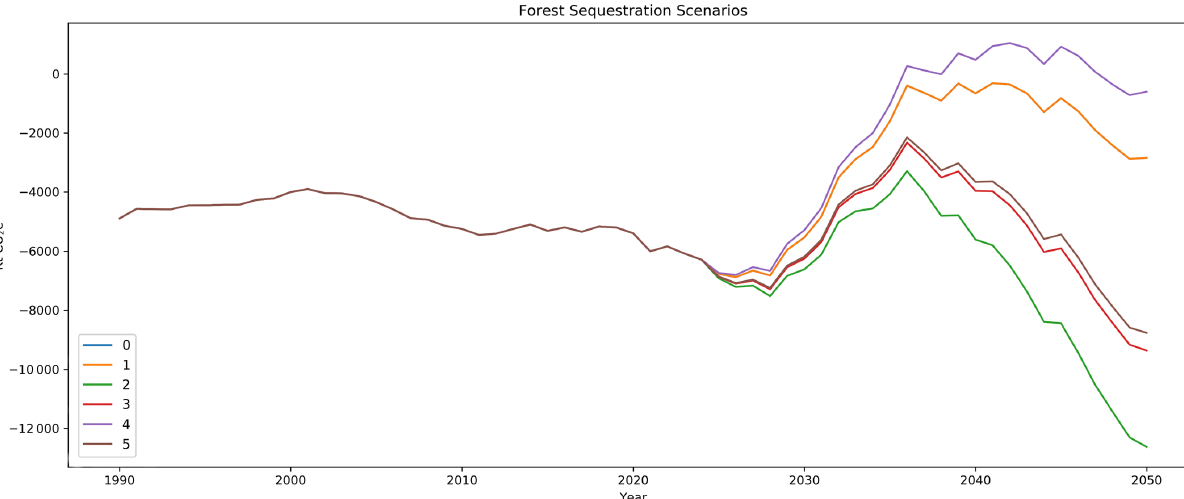
Figure 11. Net marginal GHG removals (accounted for as CO 2 e balance) from forestry between 1990 and 2050 across scenarios.